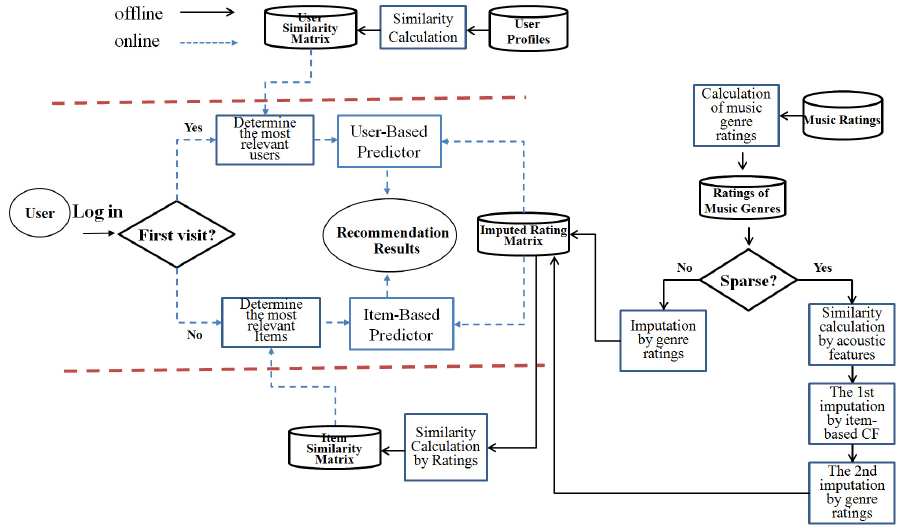
Fig. 2. Framework of the proposed music